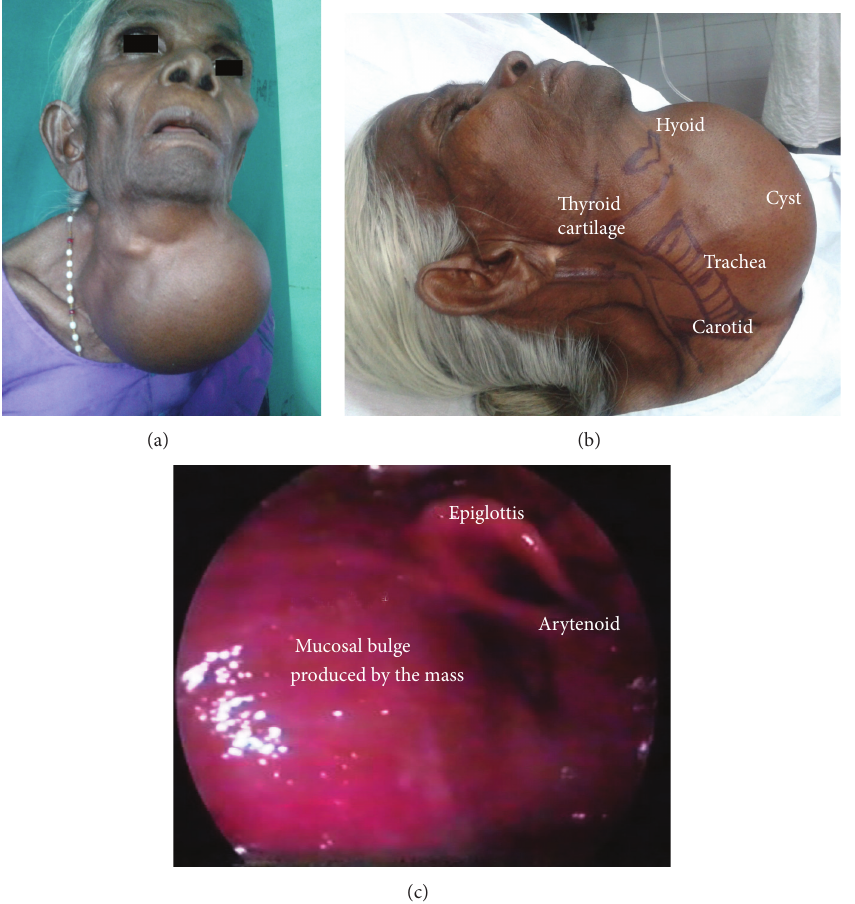
Figure 1: (a) Patient with neck mass. (b) Surface marking of neck structures displaced and distorted by the cyst. (c) Endolaryngeal picture showing airway